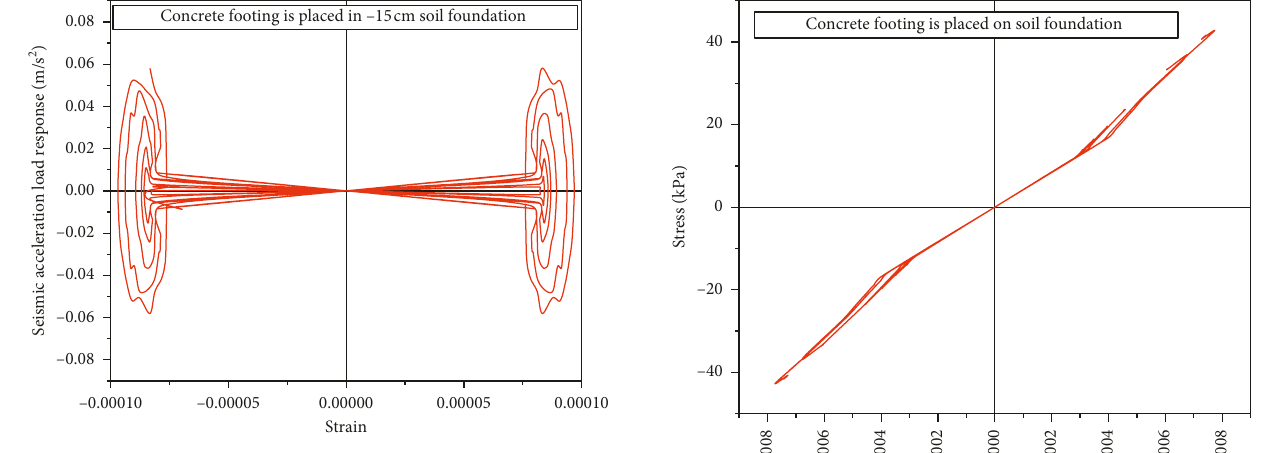
Figure 9: Seismic acceleration load response vs strain at the base of a concrete footing, during concrete footing-soil foundation